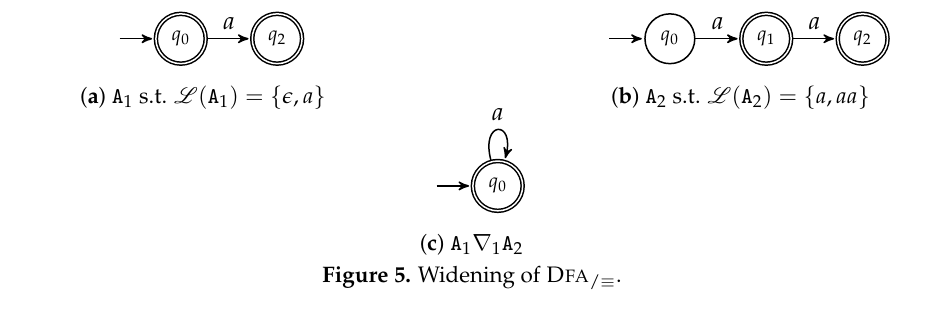
Figure 5. Widening of D FA / ≡